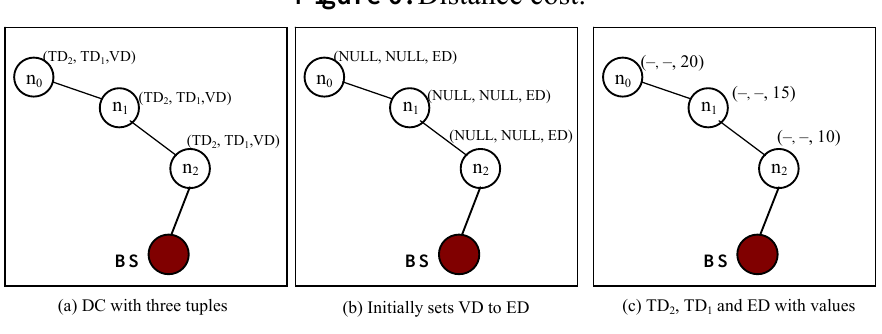
Figure 6. Distance